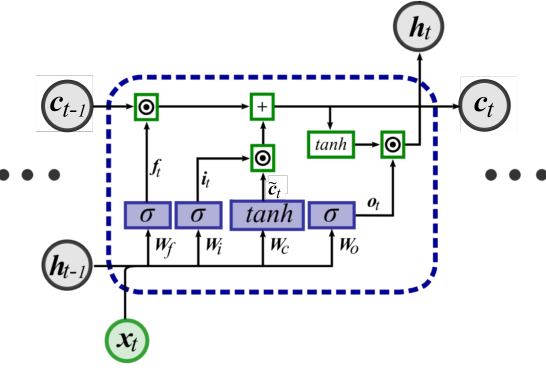
Figure 1. LSTM structure diagram.